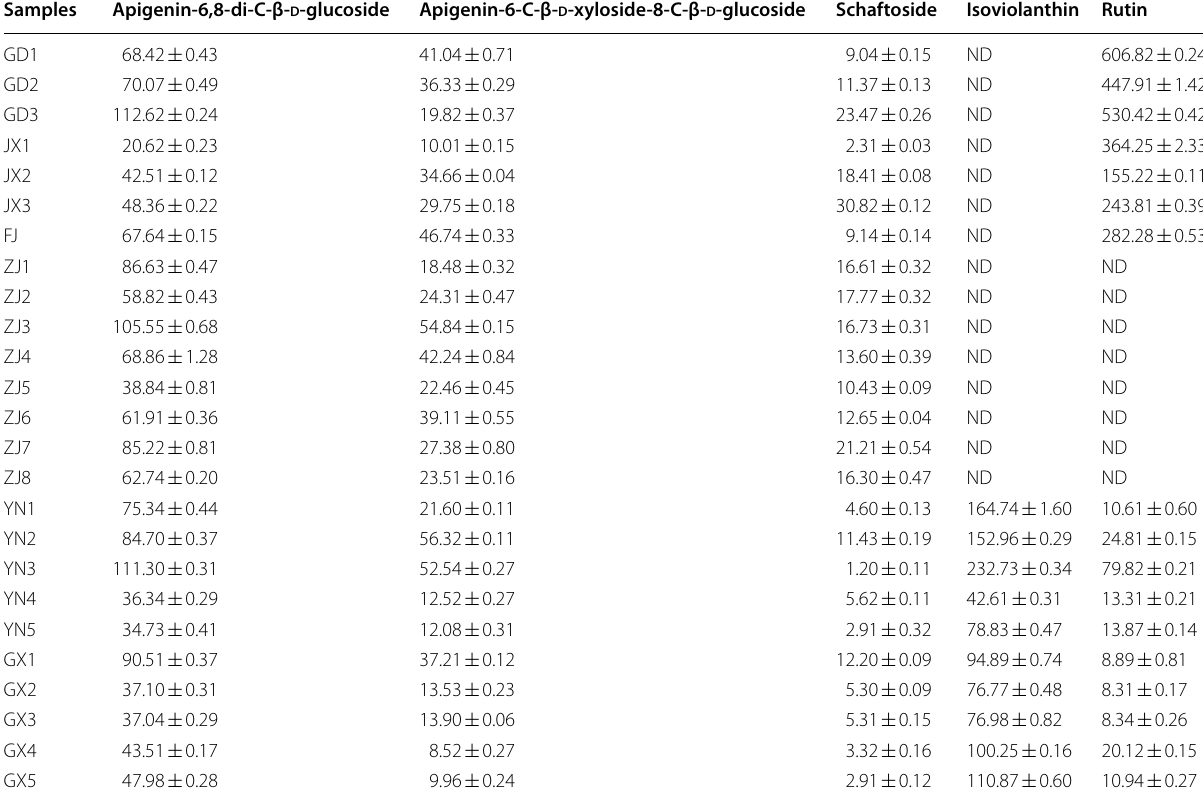
SD (n 3)] of 5 flavonoids in samples 1–25 ± =